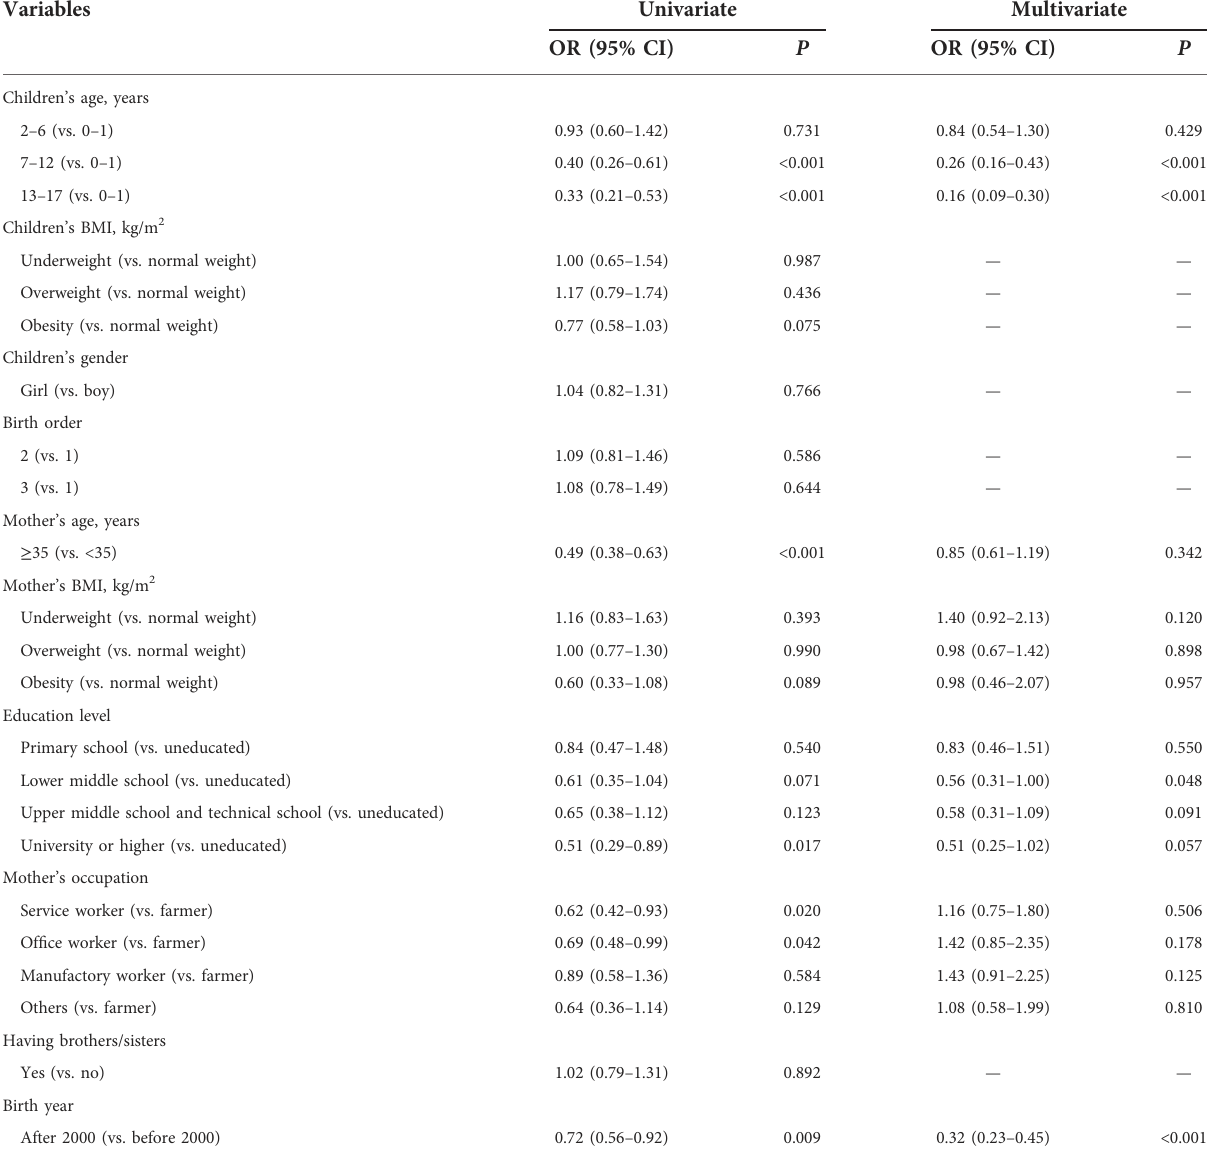
TABLE 3 Exploring in fl uence factors for URTI in urban